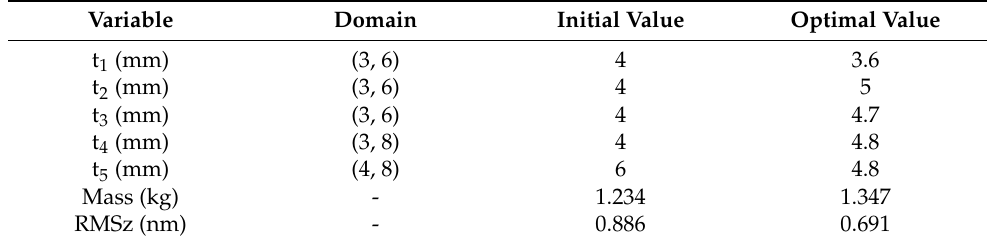
Table 2. Design variable and optimization results.